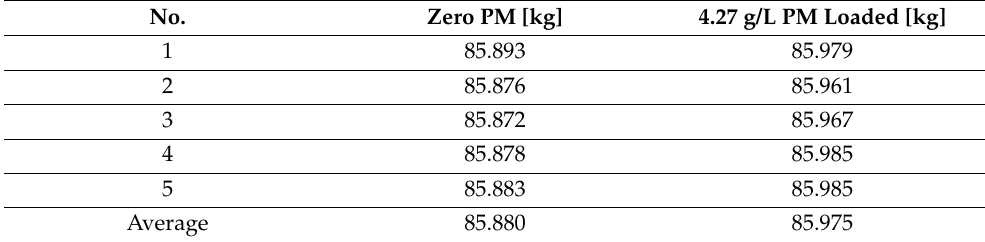
Table 3. Mass of DPF: PM unloaded vs. loaded.